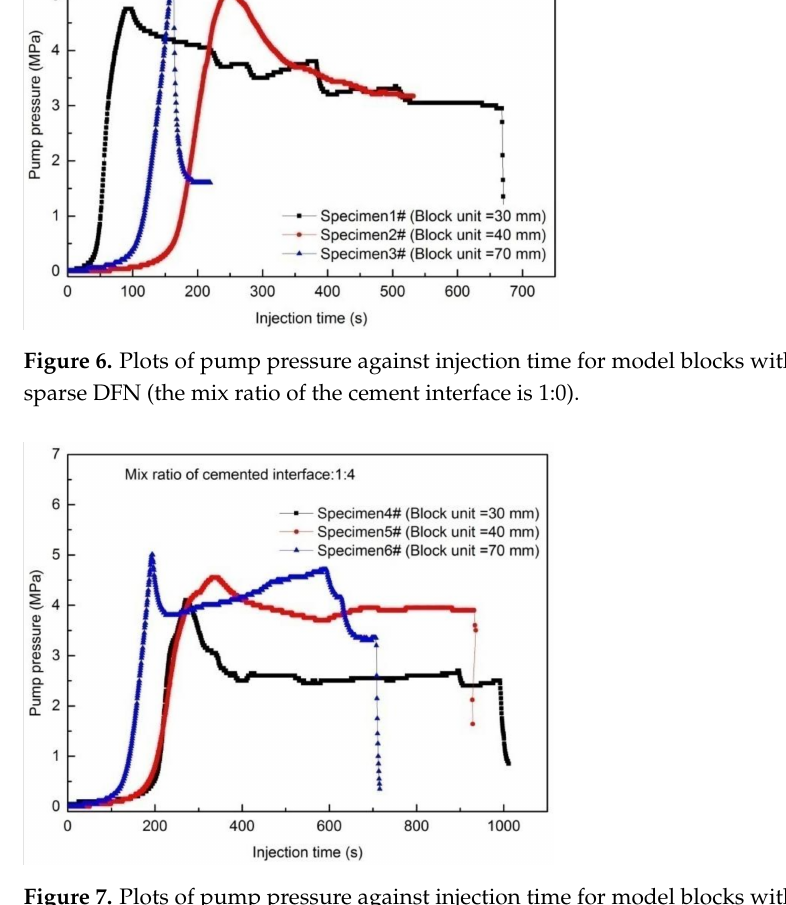
Figure 7. Plots of pump pressure against injection time for model blocks with dense, medium, and sparse DFN (the mix ratio of cemented interface is